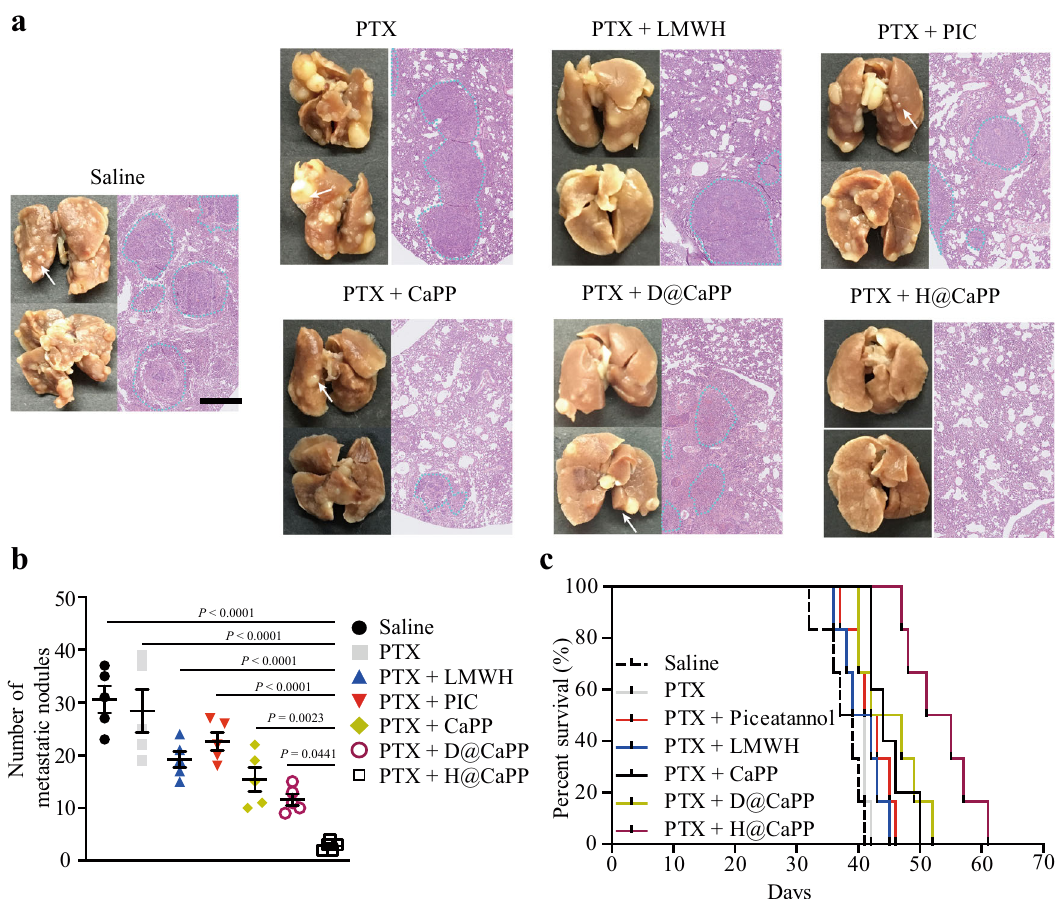
Fig. 9 H@CaPP combined with chemotherapy achieved the anti-metastasis therapeutic effect in orthotropic primary tumor-bearing mice. a Typical lung tissues with visualized metastatic nodules (white arrows) from each group, and representative fi elds of lung tissues with metastasis areas (blue dotted lines) from each group with H&E. Black scale bar, 5 mm; Scale bar, 0.5 mm. b The number of metastatic nodules from the mice after intravenously administration with saline, PTX, PTX + LMWH, PTX + PIC, PTX + CaPP, PTX + D@CaPP or PTX + H@CaPP (i.v. of PTX at 5.9×10 − 3 mmol/kg, at a dose of piceatannol or PP at 0.020 mmol/kg, at a dose of Dextran or LMWH at 10 mg/kg) for seven times in 14 days (ANOVA, mean ± SD, n = 5 mice per group). c Survival curve of orthotropic breast tumor-bearing mice after intravenously administration with saline, PTX, PTX + LMWH, PTX + piceatannol, PTX + CaPP, PTX + D@CaPP, or PTX + H@CaPP for seven times during 14 days ( n = 6 mice per group). One-way ANOVA with Tukey ’ s multiple comparisons test (one-sided) was used for b . Error bars represent